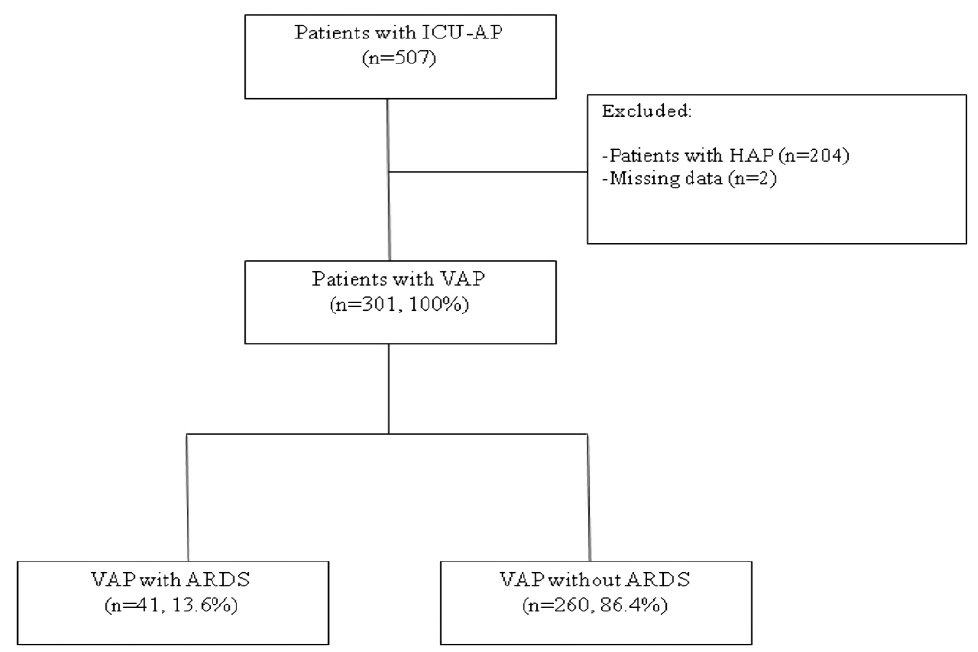
Figure 1. Flow diagram of the study population. Abbreviations: ARDS, acute respiratory distress syndrome; HAP, hospital-acquired pneumonia; ICU-AP, intensive care unit-acquired pneumonia; VAP, ventilator-associated pneumonia.